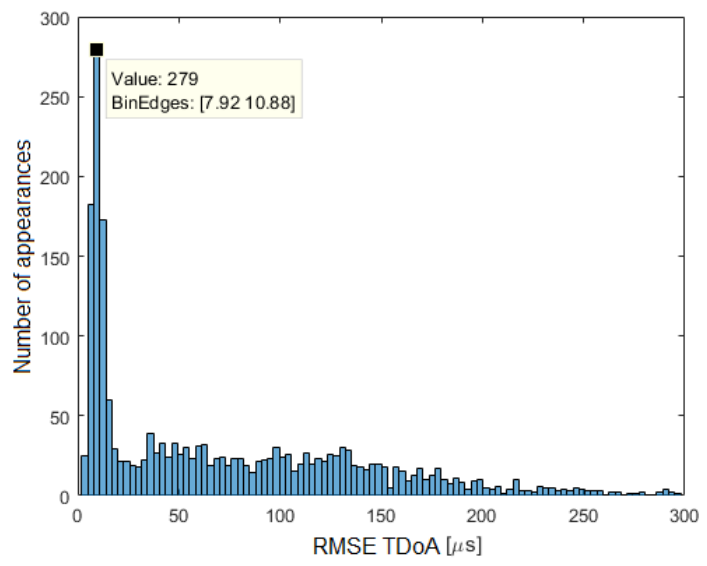
Figure 19. Distribution of TDoA estimation error from collected data over a one-month period.